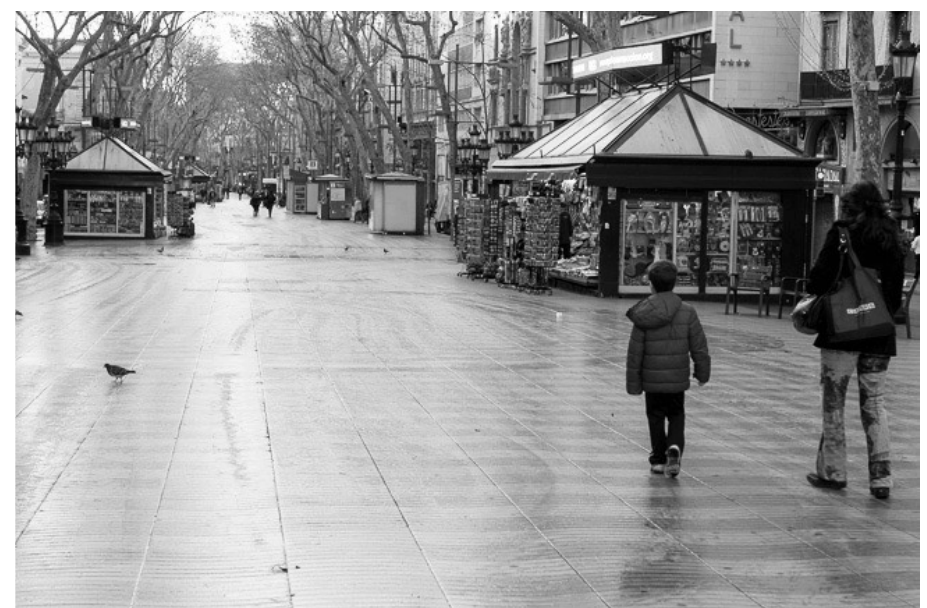
Figure 12. Does the Rambla of the future exist, maybe just an early Sunday morning? Source: Barcelona Experience (2017). with social movements, since the battle to fight against capitalist urbanization is not only theoretical (Figure 13).